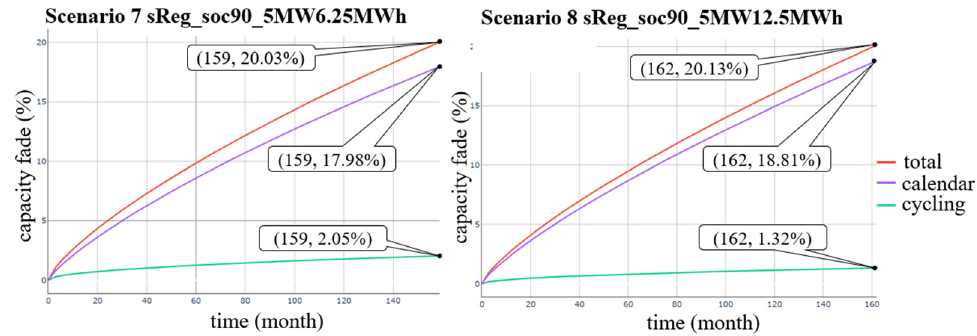
Figure 19. The aging ratio of Scenarios 7 and 8.